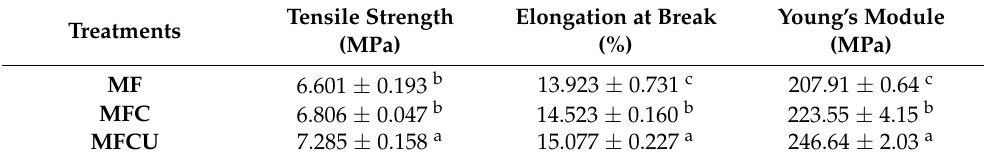
Table 2. Mechanical properties of mung bean flour-based films processed under different